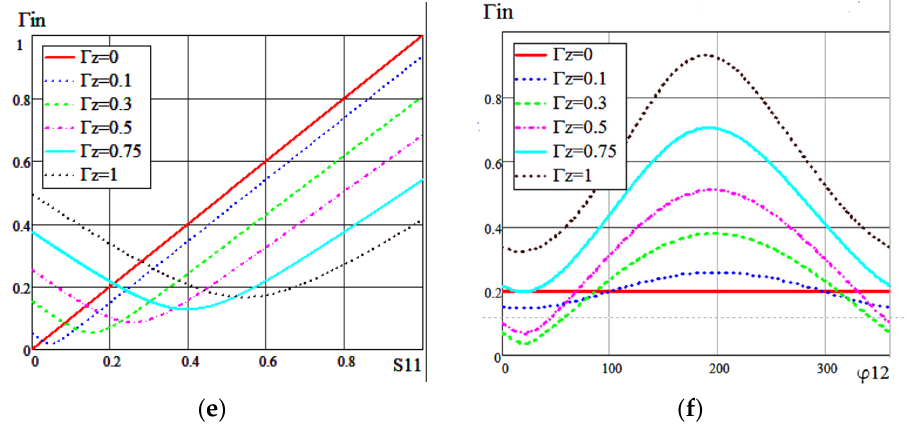
Figure 3. Magnitude of the input reflection coefficient of a long microwave path depending on: ( a ) S (cid:2870)(cid:2869) ; ( c ) φ (cid:2870)(cid:2869) ; ( d ) φ (cid:2869)(cid:2870) ; ( e ) S (cid:2869)(cid:2869) and phase depending on: ( b ) φ (cid:2870)(cid:2869) ; ( f ) φ (cid:2869)(cid:2869) .